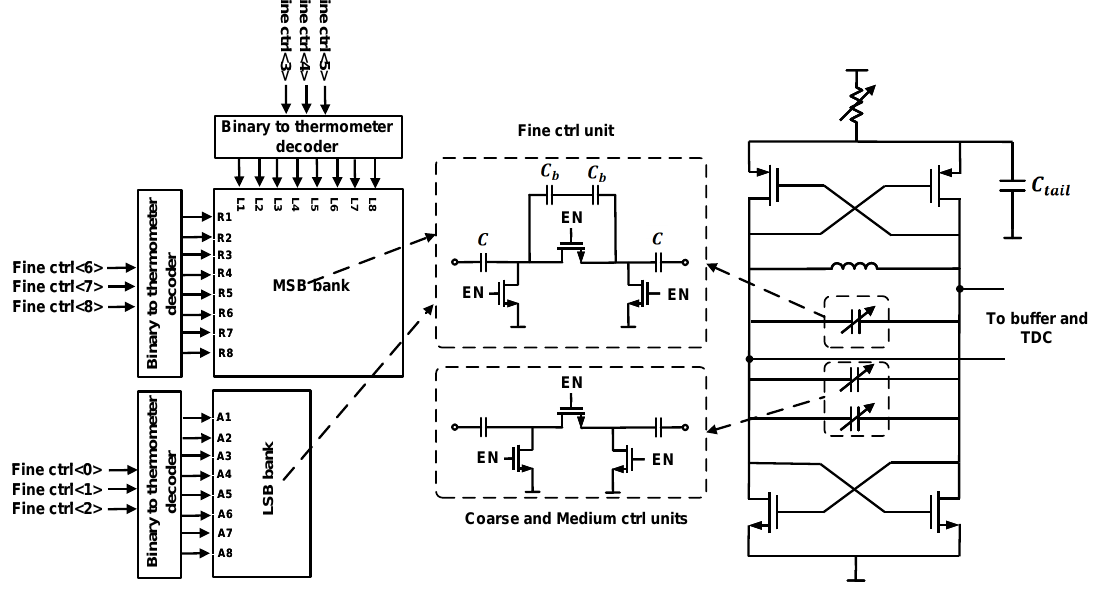
Figure 13. Circuit of the